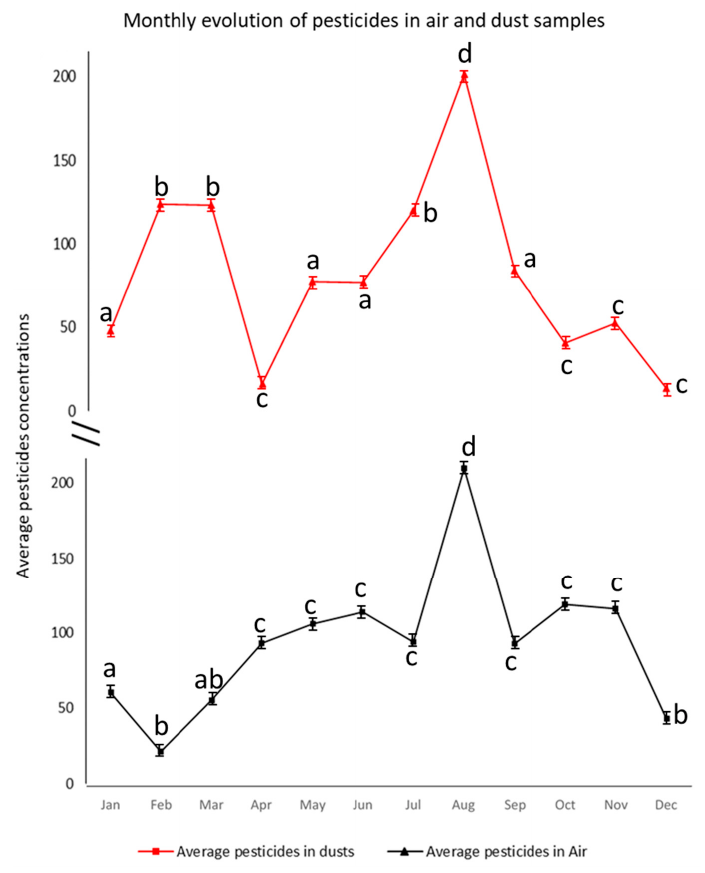
Figure 6. Monthly evolution of the average of the pesticides detected in the dust (ng g − 1 ) and air (ng sampler − 1 ) samples; differing lowercase denotes the means of averages that are significantly different ( p < 0.05) between each month.